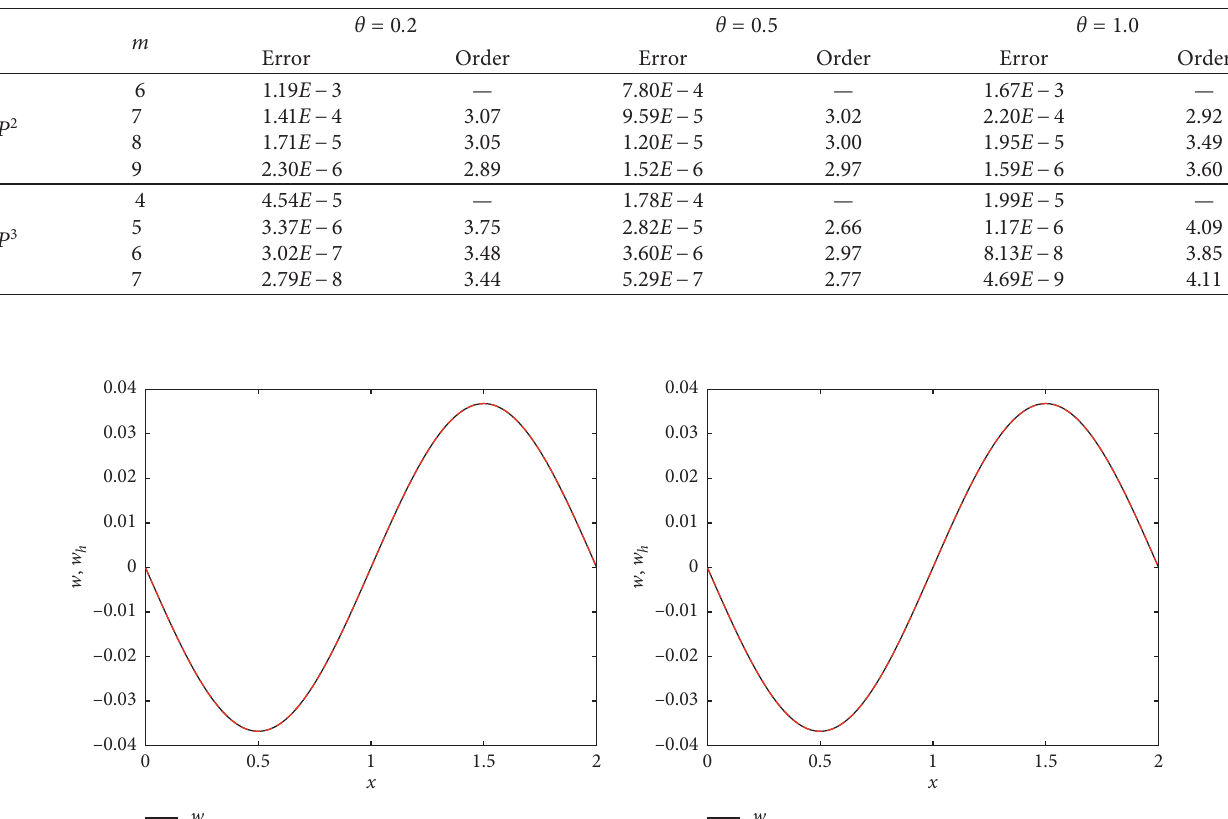
Table 3: The L 2 spatial errors and order of convergence of p